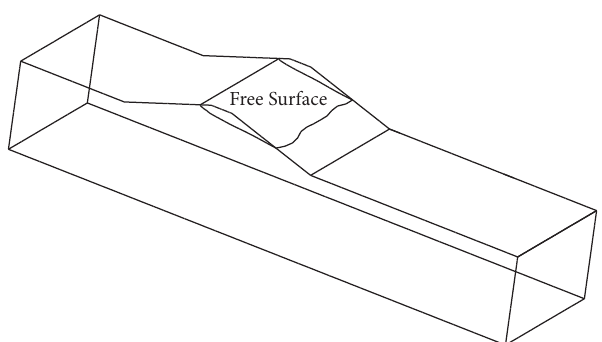
Figure 4: Free surface of three-dimensional random seepage